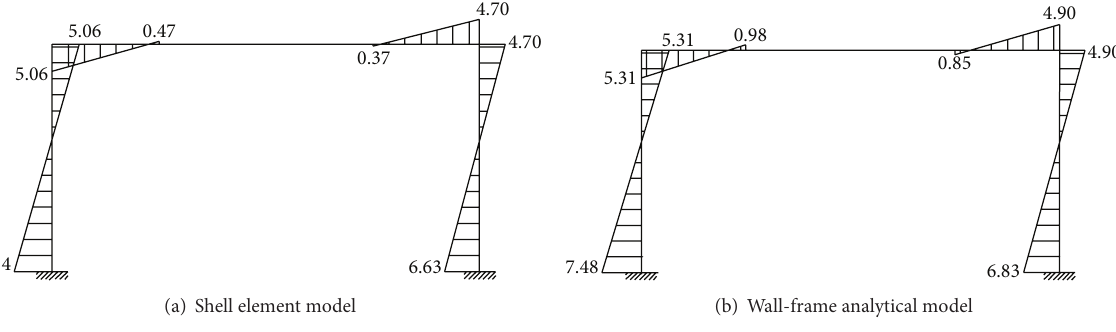
Figure 16: Moment diagrams of the steel frame under the drift angle of 1/500 (kN ⋅